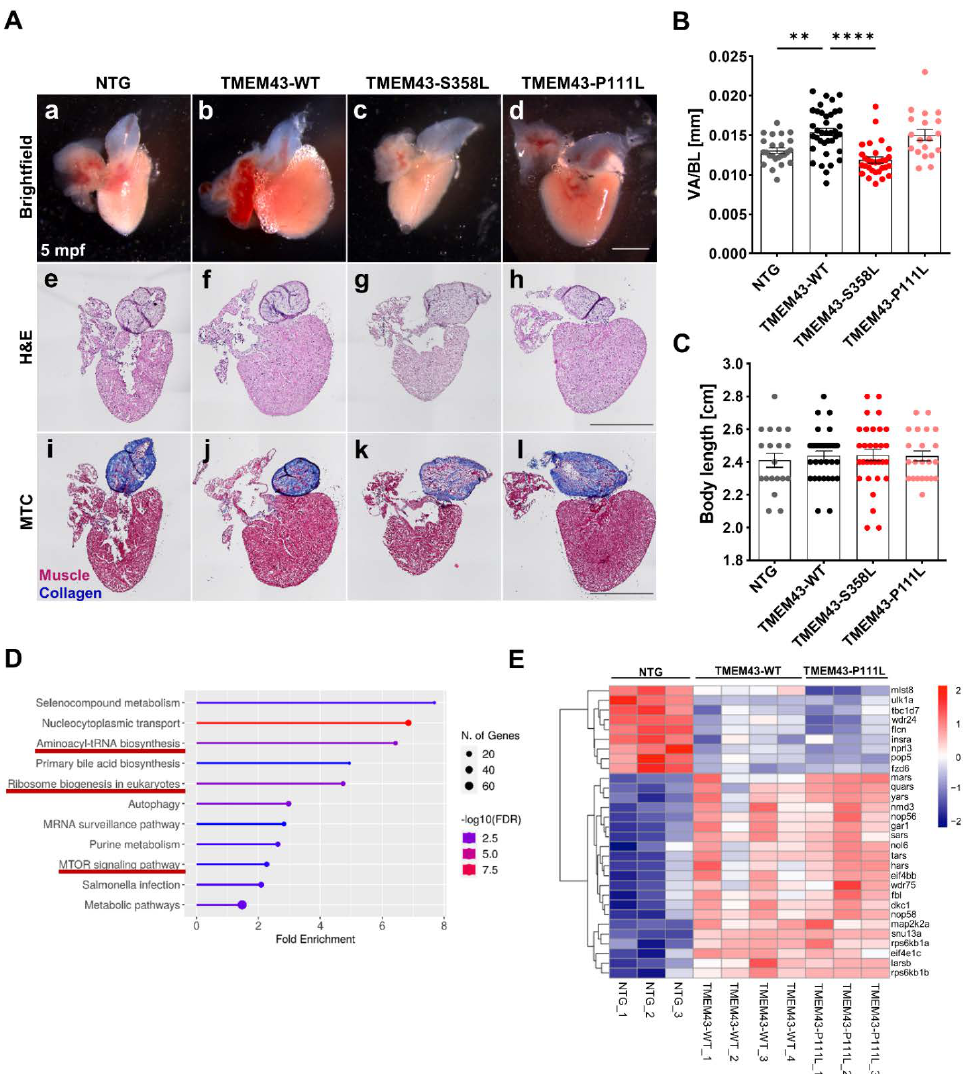
Figure 5. TMEM43 wild-type (WT) and TMEM43-P111L transgenic lines display enlarged hearts in adult zebrafish. ( A ) Preserved myocardial structure in adult zebrafish at 5 months post-fertilization (mpf) ( n ≥ 5 hearts per genotype). Scale bars = 500 µm. ( a – d ) Representative brightfield images of dissected fish hearts. ( e – h ) Histology was analyzed by hematoxylin and eosin (H&E) staining. ( i – l ) Fibrosis was analyzed by Masson’s Trichrome (MTC) staining. ( B ) TMEM43-WT and TMEM43- P111L individuals display larger ventricles as indicated by an increased ventricular area to body length ratio (VA/BL) compared to the non-transgenic control (NTG) and TMEM43-S358L. Brightfield images represented in ( a – d ) were used for assessment of ventricular surface area. ( C ) Quantification of body length reveals normal growth and development of adult transgenic zebrafish. ( D ) Kyoto Encyclopedia of Genes and Genomes (KEGG) pathway enrichment analysis for shared differently ex- pressed genes (DEGs) between “NTG vs. TMEM43-WT” and “NTG vs. TMEM43-P111L” (p adj ≤ 0.05) using ShinyGO v0.76. The x-axis represents fold enrichment and y-axis represents enriched KEGG terms. The size of the dots represents the number of involved genes. The false discovery rate (FDR) value is indicated by colors.KEGG pathways, which include the DEGs shown in ( E ), are underlined in red and play a role for cell growth. ( E ) Heatmap showing DEGs belonging to the KEGG pathways “Aminoacyl-t-RNA biosynthesis”, “Ribosome biogenesis in eukaryotes”, and “mTOR signaling path- ways”. ( B , C ) For all graphs, significance was determined by one-way ANOVA with Bonferroni’s multiple comparison test, ** p ≤ 0.01, **** p ≤ 0.0001. Error bars correspond to